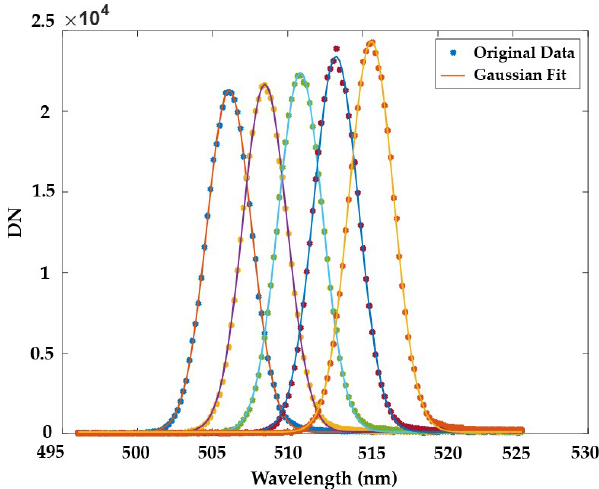
Figure 8. Spectral response curve of the left subsystem at Band 51–55 (mean full width at half maximum (FWHM) is 3.48 nm).